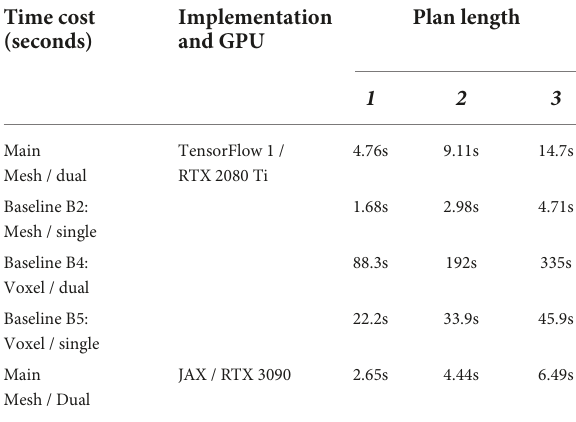
TABLE 5 Planning time